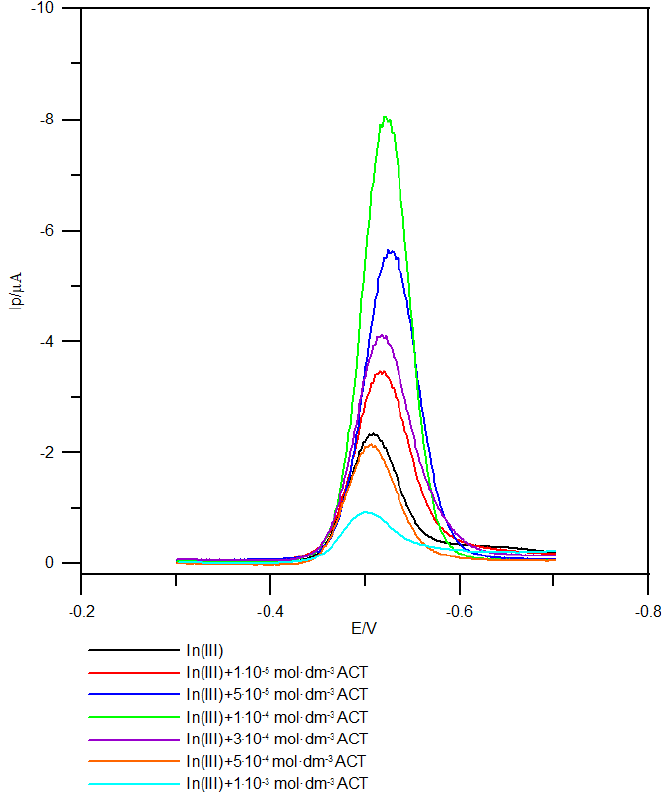
Figure 2. SWV voltammograms of 1 × 10 − 3 mol · dm − 3 In(III) electroreduction in 1 mol · dm − 3 chlorates(VII) solution in the acetazolamide presence. The concentrations of acetazolamide are given on the plot.